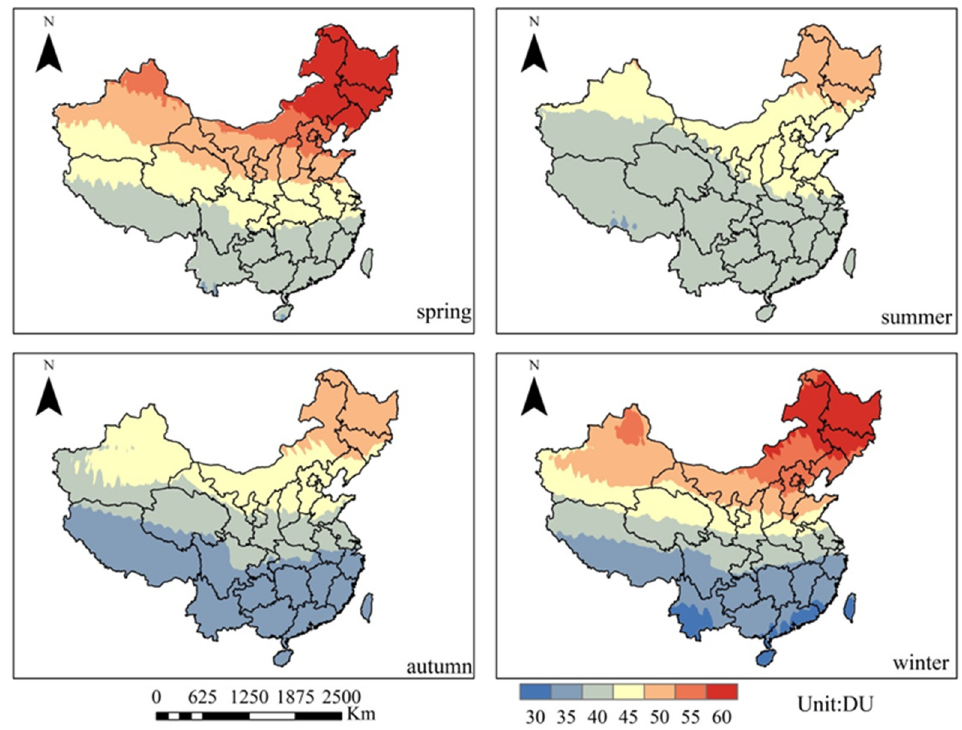
Figure 6. The seasonal spatial distributions of TCO concentration in China.